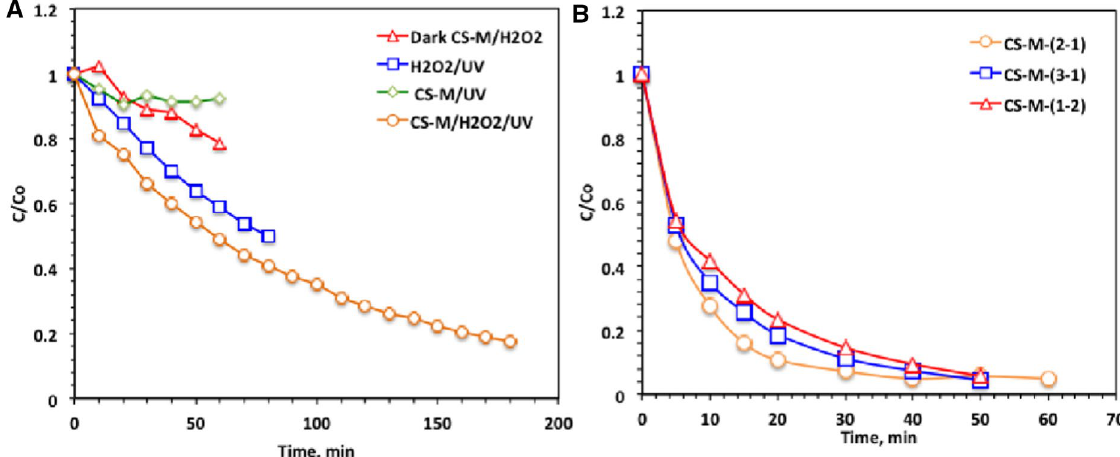
Fig. 4 Effect of reaction time on A different oxidation systems; B different Fenton’s-based chitosan/Fe